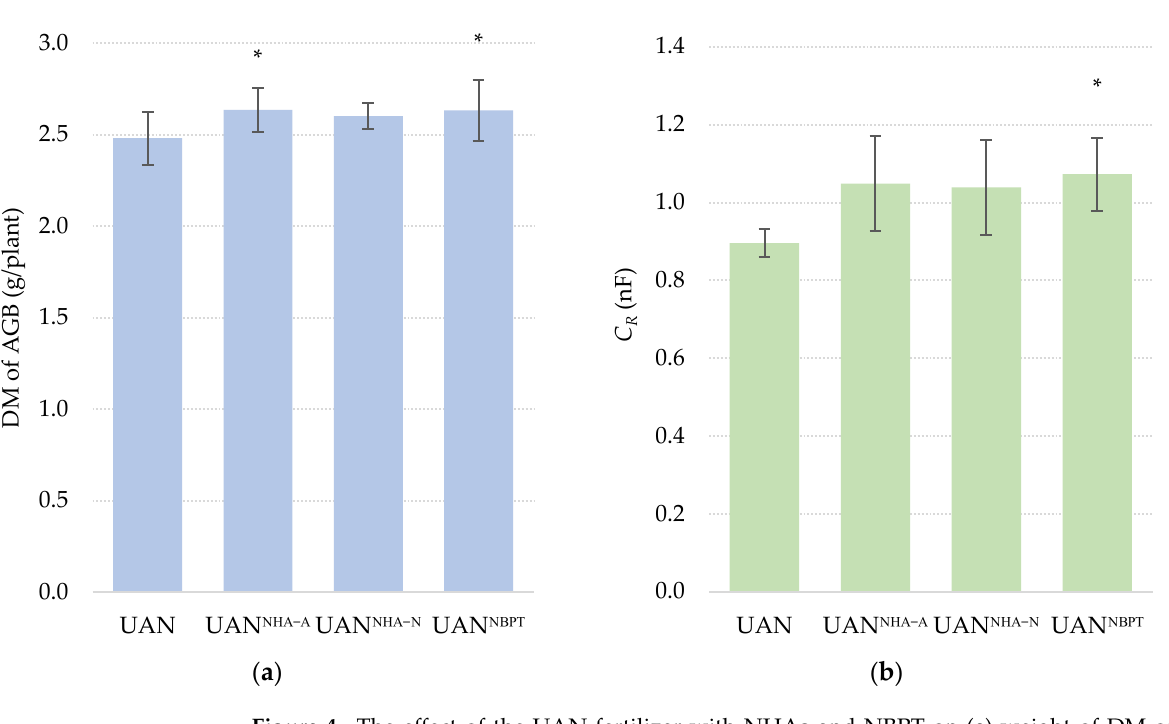
Figure 4. The effect of the UAN fertilizer with NHAs and NBPT on ( a ) weight of DM of AGB, and ( b ) root electrical capacitance of maize ( C R ). The columns represent the mean ( n = 12); error bars present the mean standard deviation. The mean values marked with asterisk are significantly different ( p ≤ 0.05) from the treatment UAN Tukey’s test.